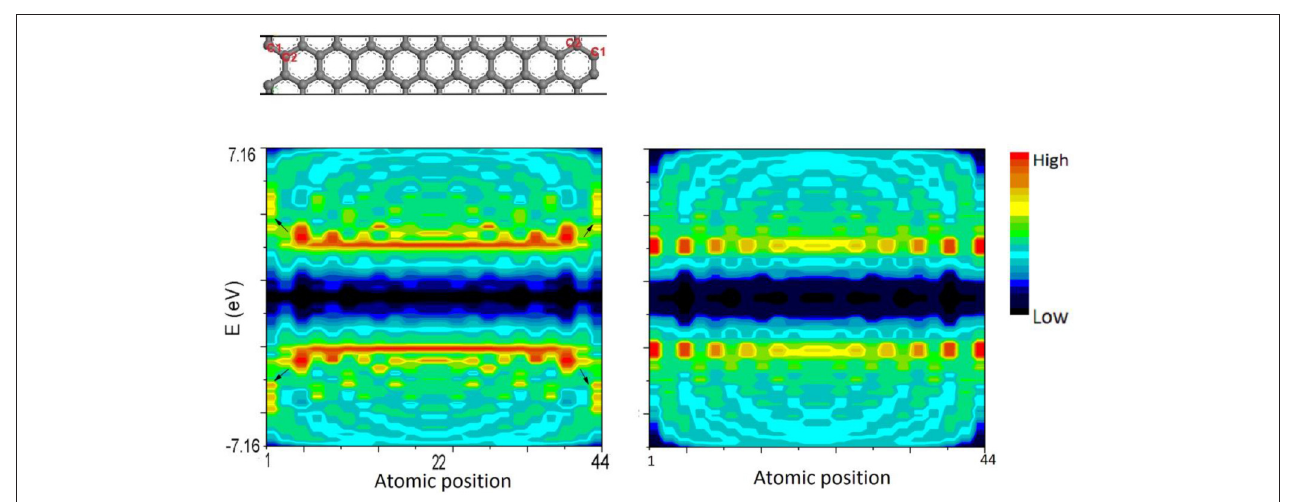
FIGURE 7 | LDOS contour of AGNR-20 calculated by BOLS-HM (left) compared with conventional TB (right) . C1 and C2 are the edge sites.